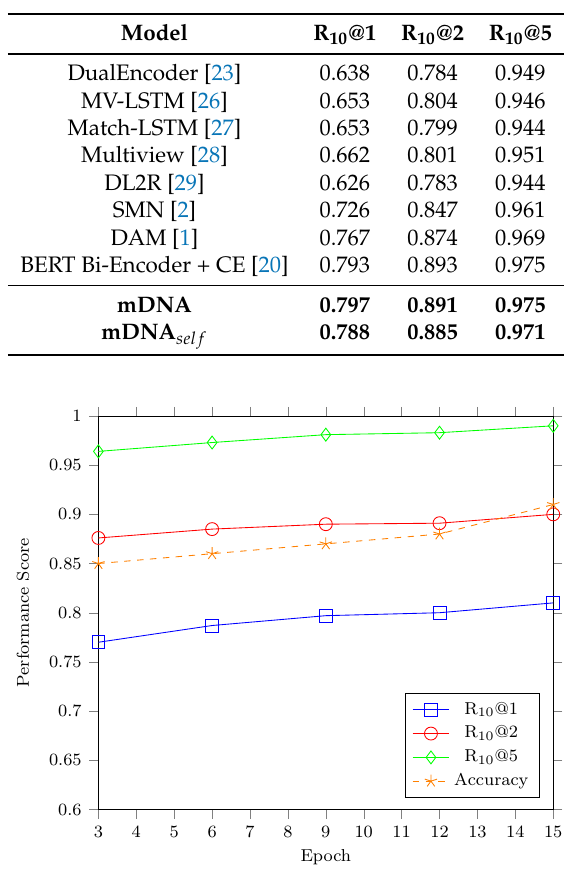
Table 3. Performance evaluation results of the mDNA and some selected retrieval chatbot models trained on Ubuntu dataset.